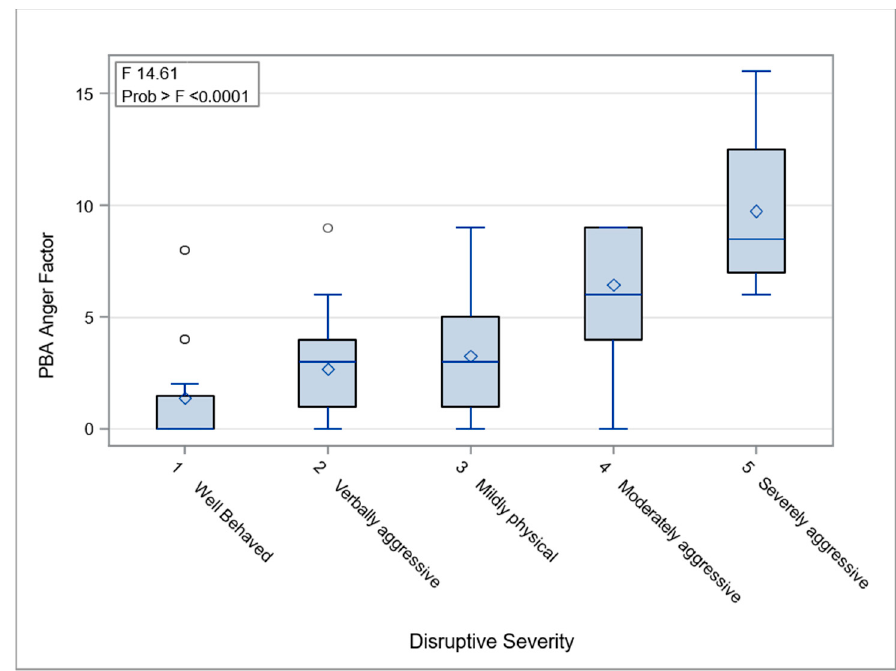
Figure 1. PBA Anger Factor Score by UHDRS Aggressive Behavior Severity at baseline. Table 4. The number of patients classified on Severity of Aggressive/Disruptive behaviors by med- ical history of violence based on UHDRS question 31.